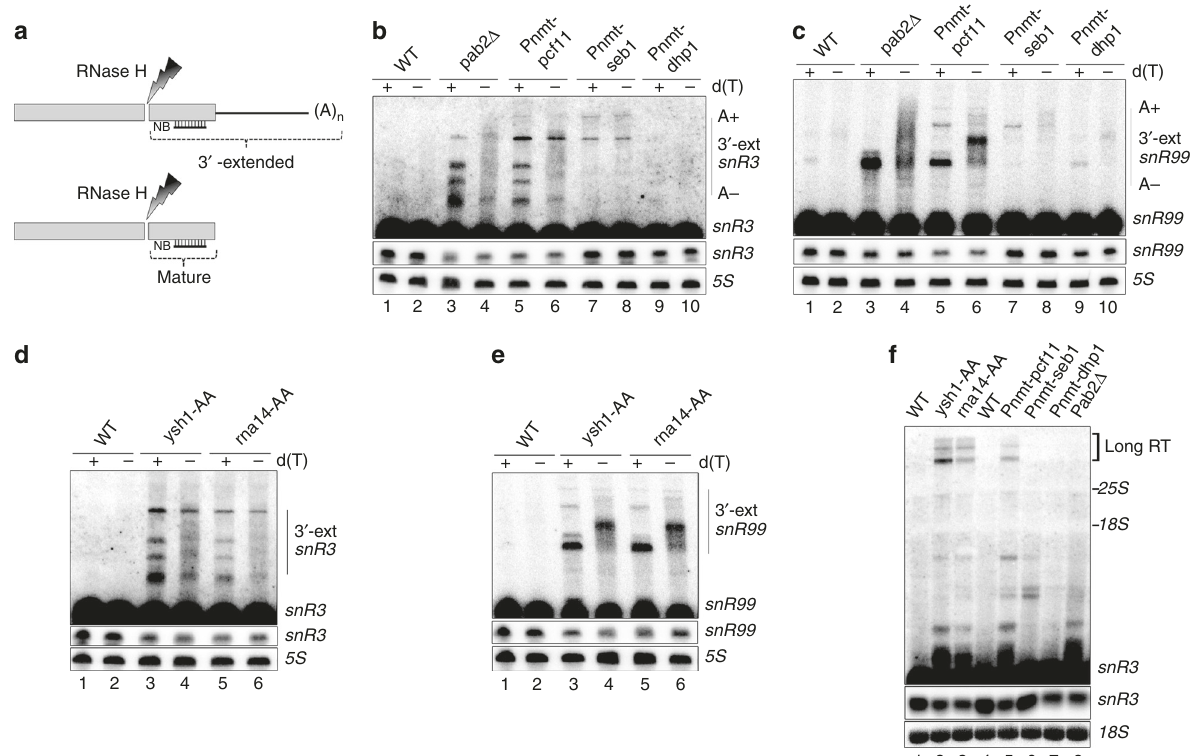
Fig. 2 The mRNA cleavage and polyadenylation complex is required for snoRNA synthesis. a Schematic of the RNase H cleavage assay used in b – e . After RNase H cleavage of the snoRNA at sites of RNA:DNA hybrids in the presence of a sequence-speci fi c DNA oligonucleotide, the 3 ′ fragment (mature or 3 ′ - extended) is detected by Northern blotting (NB). Addition of oligo d(T) to the RNase H reaction removes heterogenous poly(A) tails, generating discrete products. b , c Total RNA prepared from the indicated strains that were previously grown in thiamine-supplemented medium for 15 h to deplete Pcf11, Seb1, and Dhp1 was treated with RNase H in the presence of DNA oligonucleotides complementary to snR3 ( b ) and snR99 ( c ). RNase H reactions were performed in the presence ( + ) or absence ( − ) of oligo d(T). The top panel represents a longer exposure of the middle panel to see 3 ′ -extended (3 ′ -ext) cleavage products. The 5S rRNA was used as a loading control. d , e As described in b , c , but using cells that were previously treated with rapamycin to deplete Ysh1 and Rna14 from the nucleus. f Northern blot analysis using total RNA prepared from the indicated strains that were treated with either rapamycin (lanes 1 – 3) or thiamine (lanes 4 – 8). The blot was hybridized using DNA probes speci fi c to snR3 and the 18S rRNA. The position of mature snR3 , 18S and 25S rRNAs, as well as snR3 read-through (RT) products is indicated on the